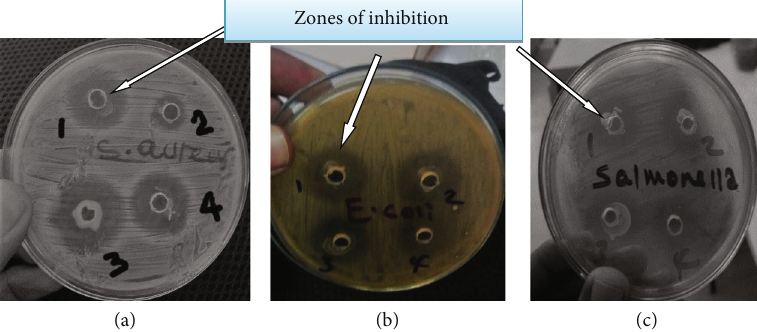
Figure 2: Combined e ff ects of antimicrobial compounds of LAB isolates against (a) S. aureus , (b) E. coli , and (c) Salmonella spp. Arrows indicate zones of inhibition. The numbers such as 1, 2, 3, and 4 show the representative LAB isolates with di ff erent sizes of zones of